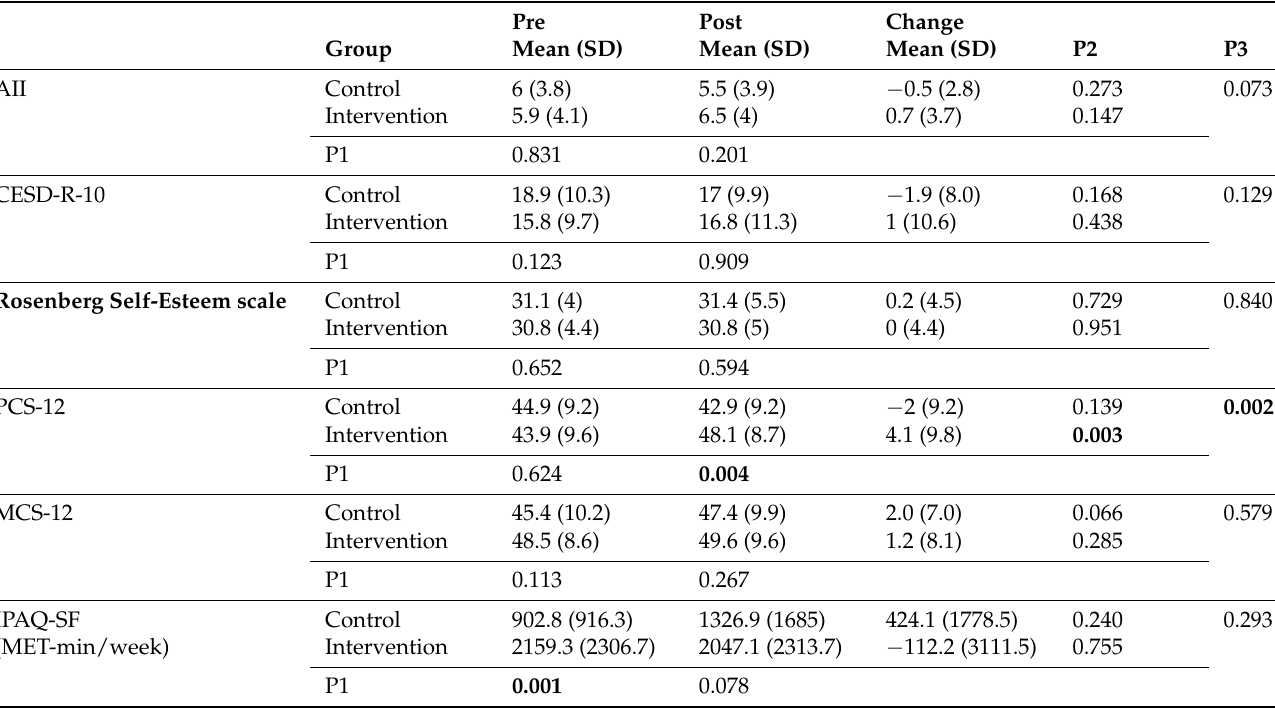
Table 7. Changes in QoL, depression, insomnia, self-esteem and physical